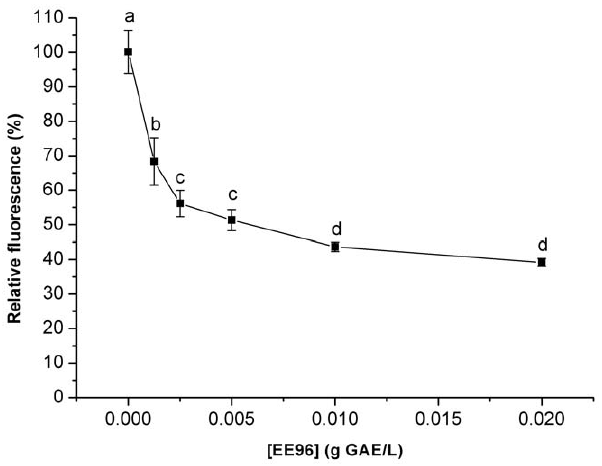
Figure 3. Intracellular oxidation in the yeast S. cerevisiae treated with EE96. Data are means (n=3) and are expressed as fluorescence relative to control. Values followed by the same letter (a– d) are not statistically different (P , 0.05), as measured by Duncan’s test.